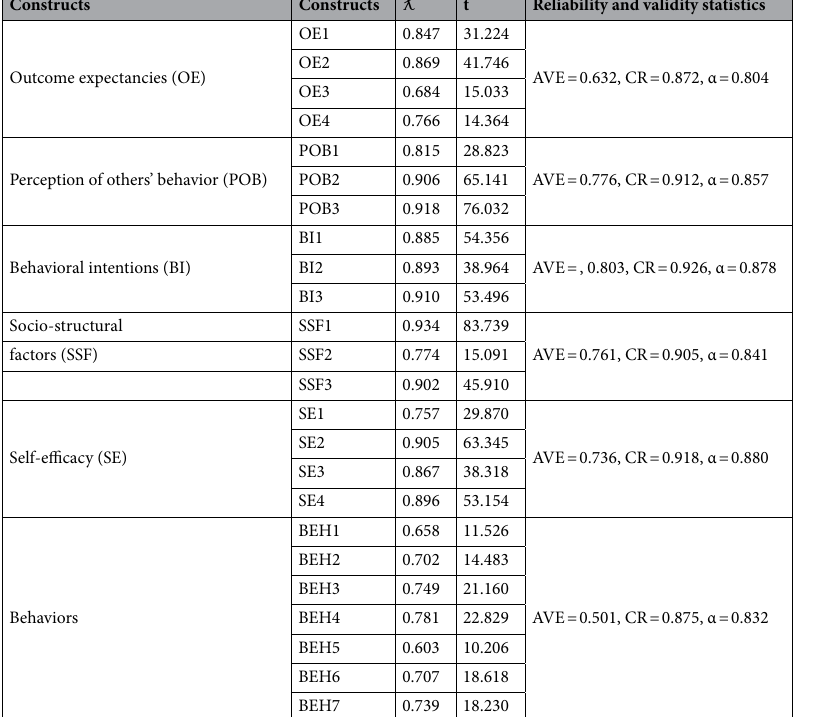
Table 4. Results of confirmatory factor analysis for the measurement model.